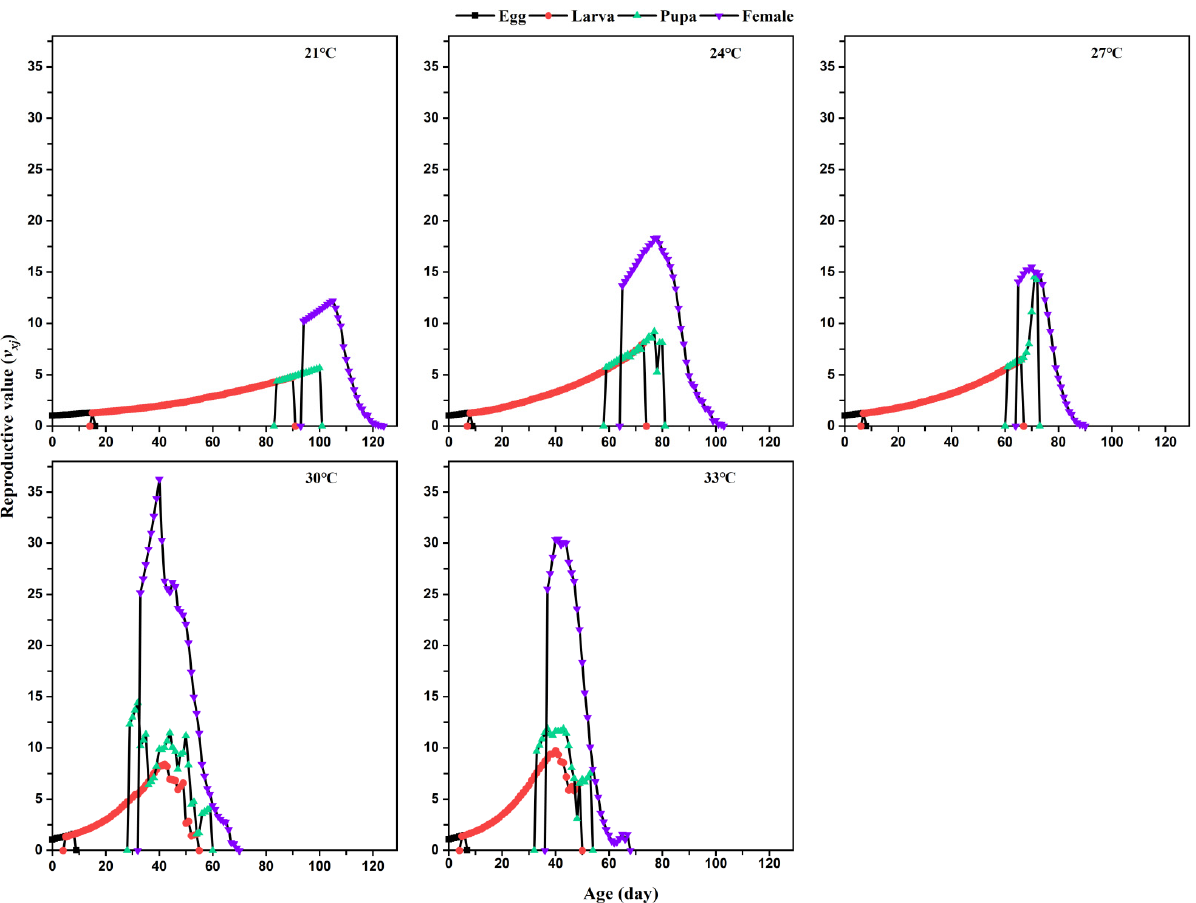
Figure 4. Age-stage specific reproductive value ( v xj ) of L. serricorne at different temperatures.